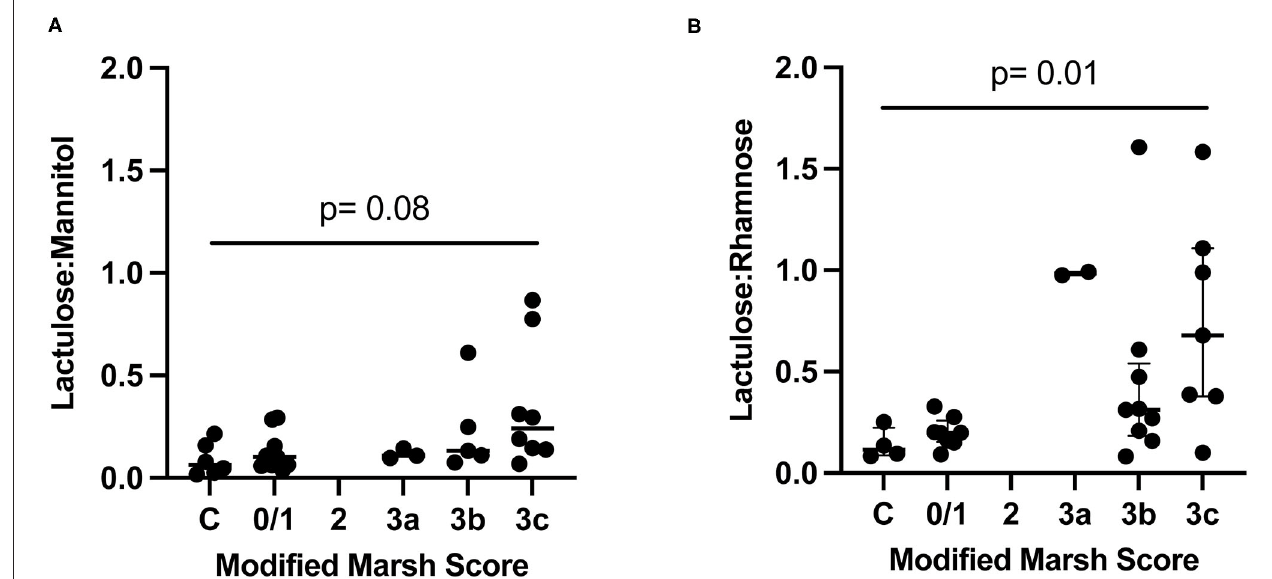
FIGURE 2 | Dual sugar testing compared to Marsh score in controls (C) and cases. P -value from Kruskal-Wallis. Lines show median and quartiles. (A) Controls and cases randomized to receive L:M. (B) Controls and cases randomized to